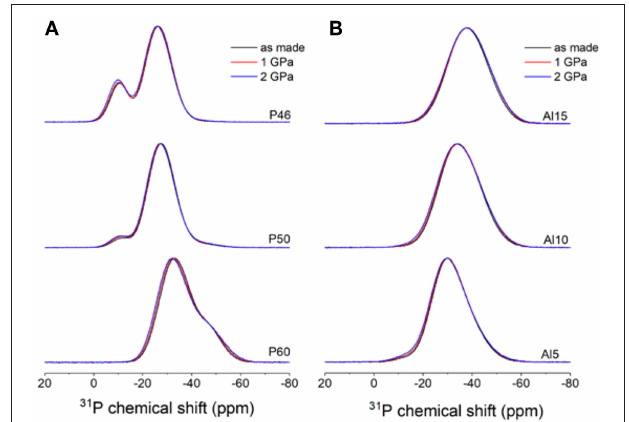
FIGURE 1 | 31 P MAS NMR spectra of the as-prepared glasses (black) and glasses hot compressed at 1 GPa (red) and 2 GPa (blue): (A) CaO-P 2 O 5 ; (B) CaO-Al 2 O 3 -P 2 O 5